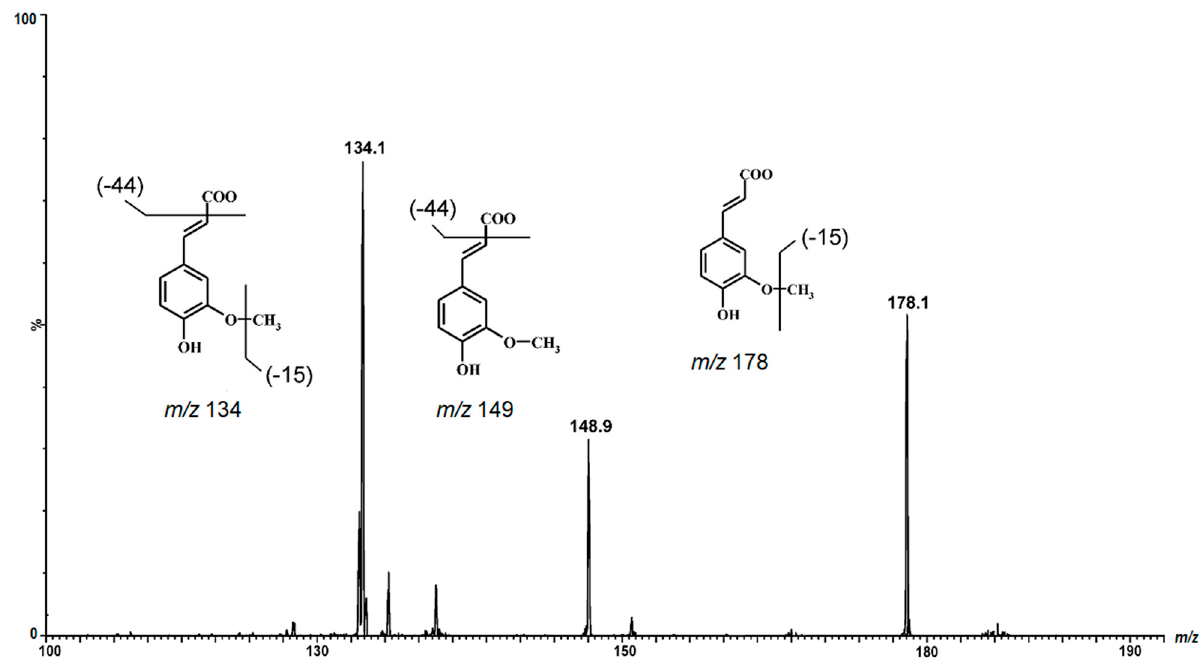
Figure 3. The ferulic acid fragmentation reaction in MRM transition.